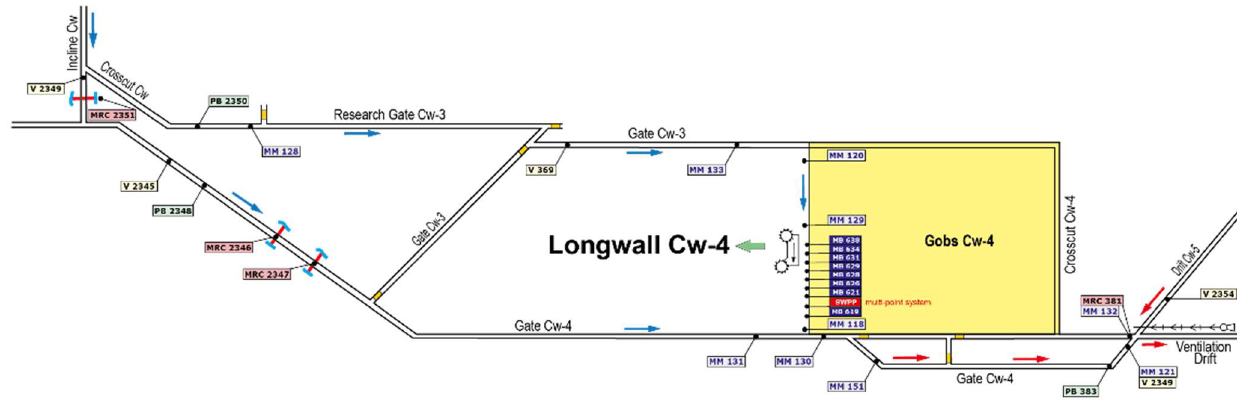
Figure 1. Diagram of the gas measurement explosion prevention system of longwall Cw-4 seam 364/2, showing the location of additional methane detecting sensors in the powered roof support sections from the gobs side.